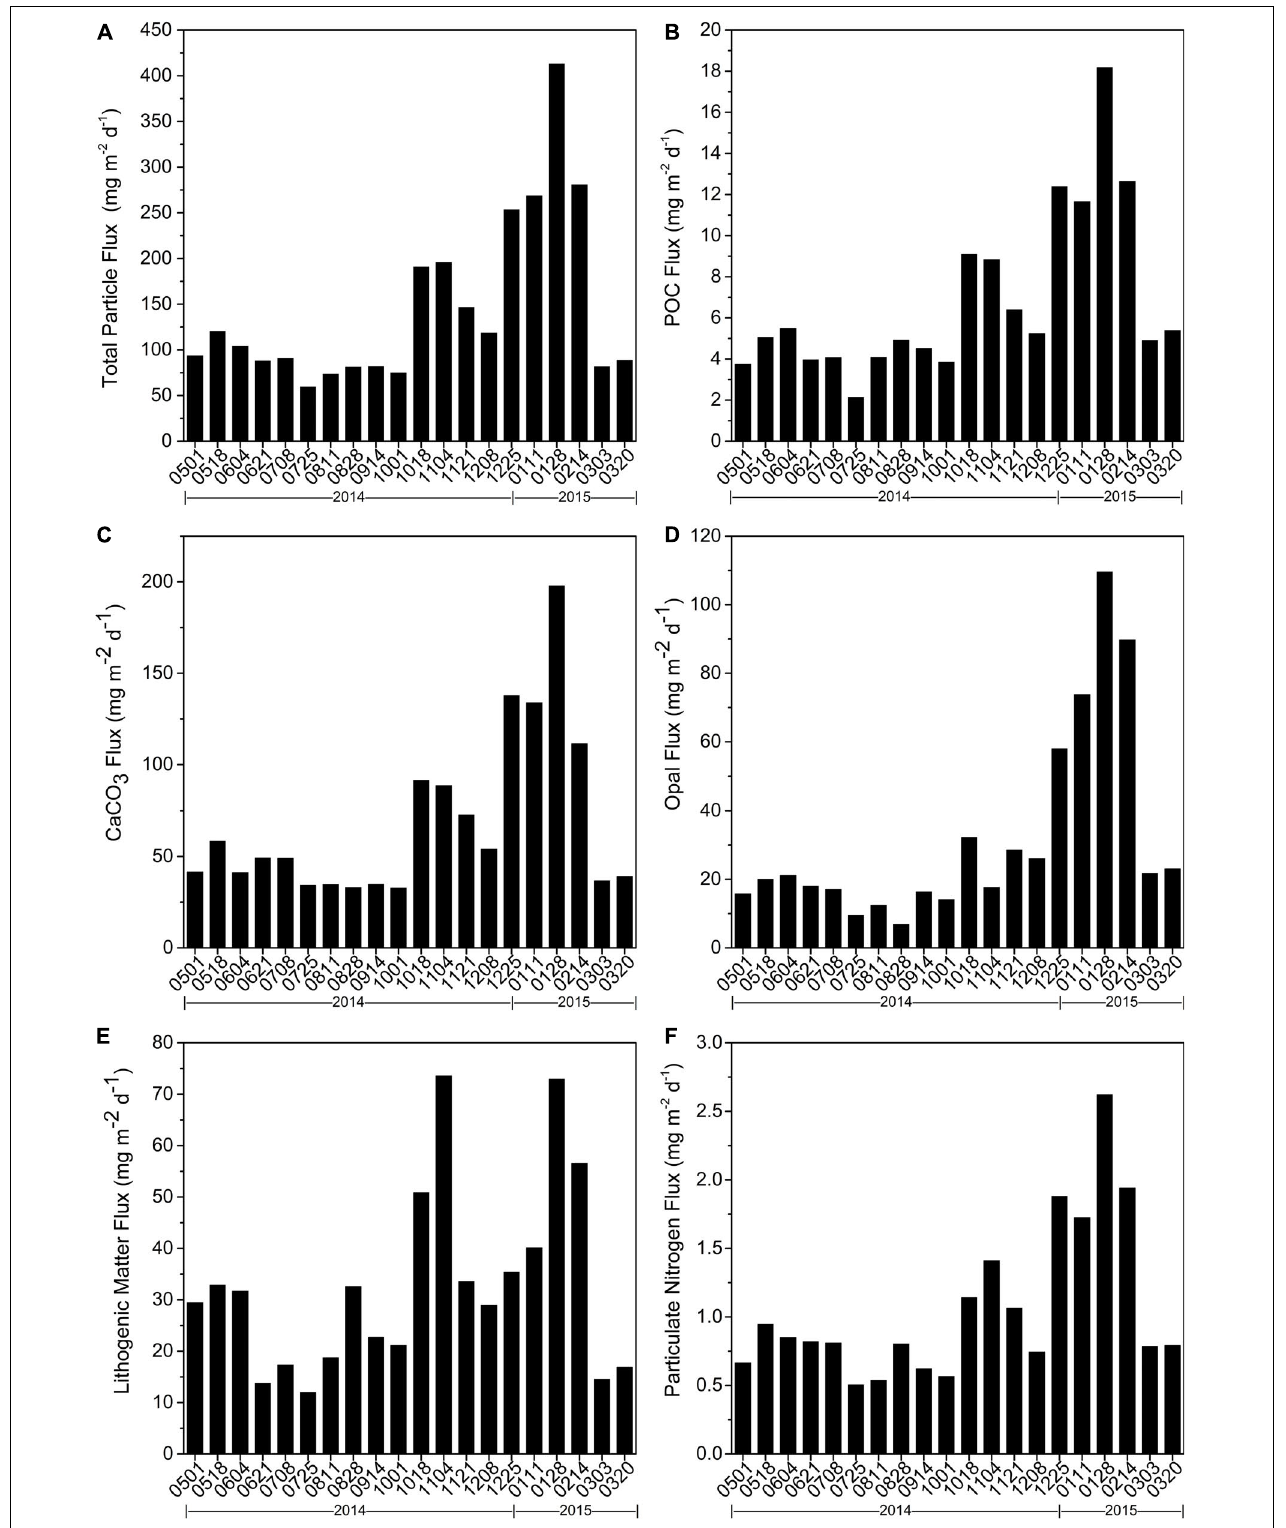
FIGURE 2 | Time Time series of particle fluxes derived from sediment trap at SCS-N station from May 01, 2014 to April 06, 2015. (A) total particle flux, (B) POC flux, (C) CaCO 3 flux, (D) opal flux, (E) lithogenic matter flux, and (F) particulate nitrogen flux. Date labels on x axis are marked as mmdd for first date of each sampling period (for this and subsequent similar figures).